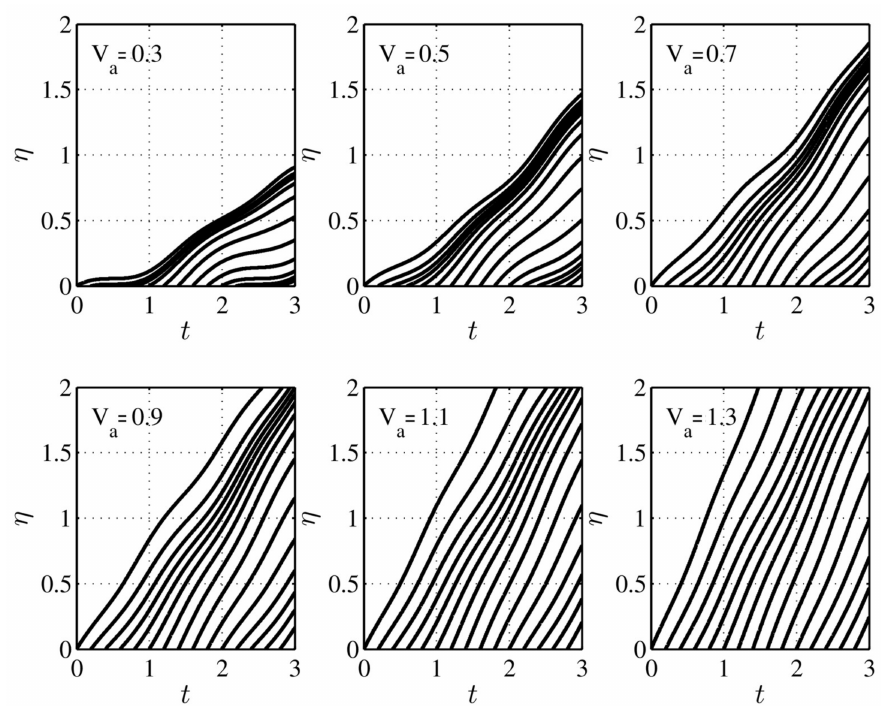
Figure 2. Influence of average velocity, V a , on characteristic curves for spray droplet dynamics in a host gas standing wave flow-field.